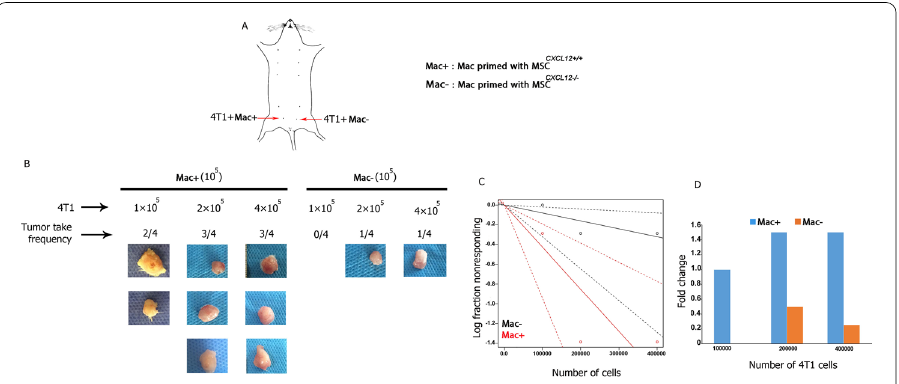
Fig. 4 Occurrence of mammary tumor in three independent cellular dilutions of MSC CXCL12+/+ and MSC CXCL12-/– primed macrophages. Schematic representation of cell injection experiments ( A ). In vivo limiting dilution assay was performed using 4T1 cells and MSC CXCL12 + / + and MSC CXCL12−/− ‑primed macrophages. Tumor frequency rate and individual tumor masses are shown in each dilution ( B ). Limiting dilution analysis using ELDA software to estimate the frequency of the tumor‑initiating cells by fitting the single‑hit Poisson model (SHPM). In this plot, regression lines and 95% confidence intervals for both groups were graphed ( C ). Average tumor occurrence of 4T1 cells coinjected with three dilutions of MSC CXCL12 + / + and MSC CXCL12-/– primed macrophages ( D ). The Y axis was generated based on the rationale that the occurrence of mammary tumor in one mouse/100 000 injected tumor cells was arbitrarily assumed as 1. Mac,